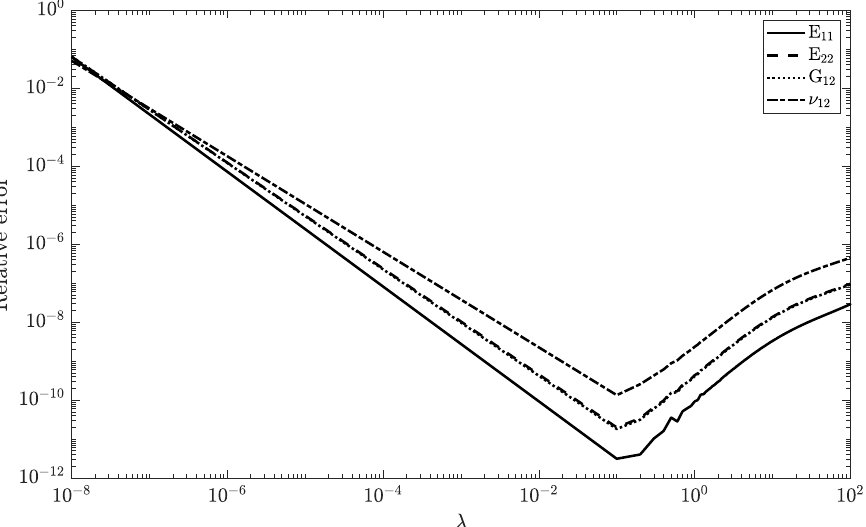
Figure 9. The relative least square error vs. regulation factor λ in Equation (8) for the ANN model in Equation (7).